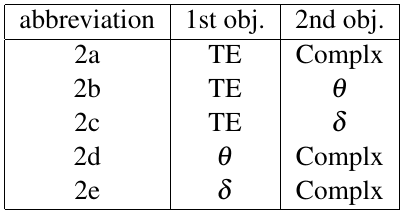
Table 1. The five fitness function